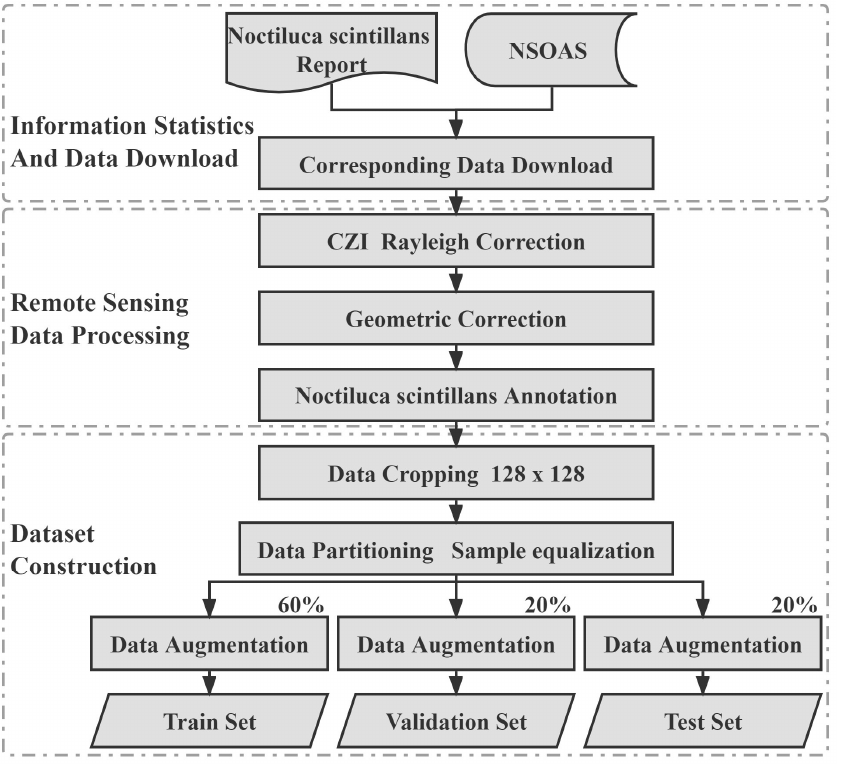
Figure 2. Flow chart of CZI data processing.